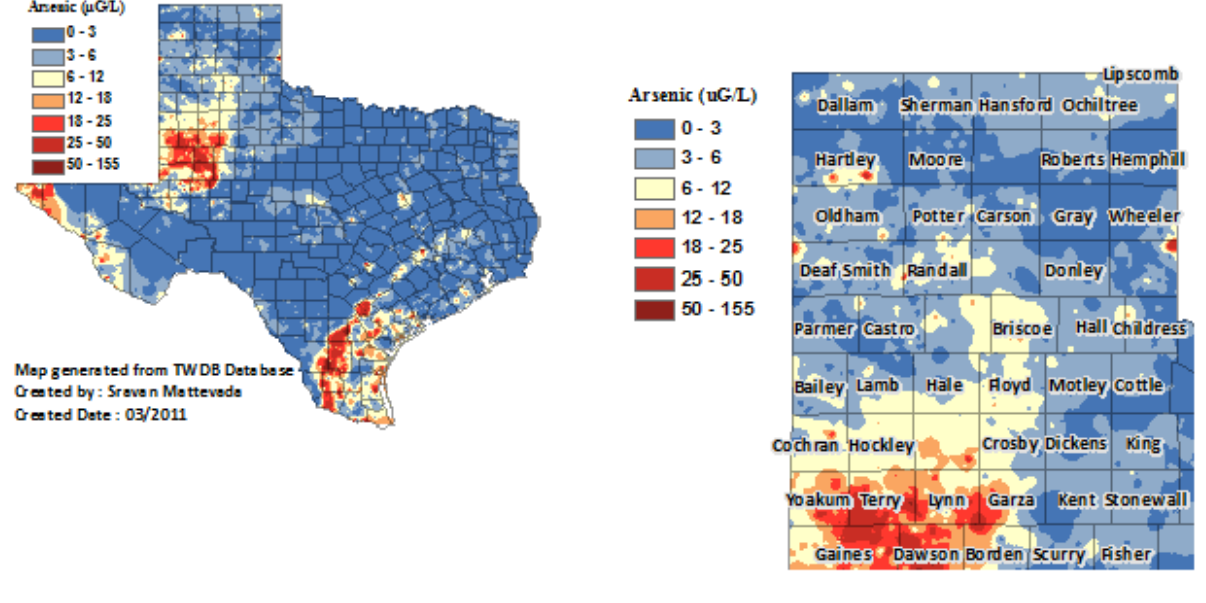
Figure 2. Ground water arsenic measurements form the Texas Water Development Board